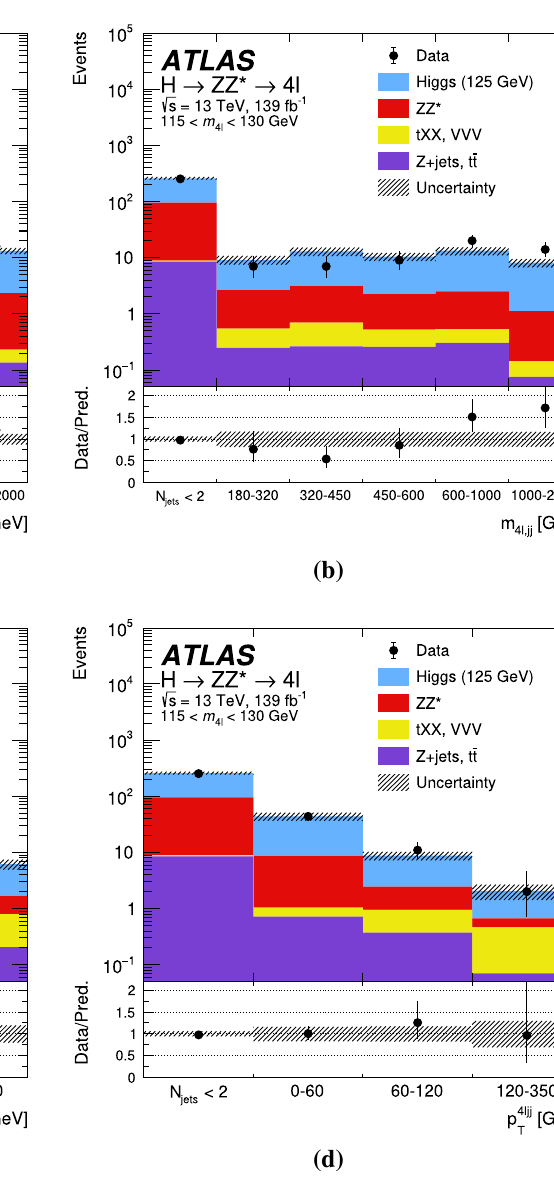
Fig. 9 The observed and expected (pre-fit) distributions of a m 4 (cid:3) j , b first bin in a and c contains events with no jets, while the first bin in (cid:3) j (cid:3) jj b and ( d ) contains events with fewer than two jets. The uncertainty in m 4 (cid:3) jj , c p 4 , and d p 4 in the mass region 115 < m 4 (cid:3) < 130 GeV, √ T T the prediction is shown by the hatched band, which includes the theo- for an integrated luminosity of 139 fb − 1 collected at s = 13 TeV. A retical uncertainties of the SM cross section for the signal and the Z Z ∗ SM Higgs boson signal with a mass m H = 125 GeV is assumed. The